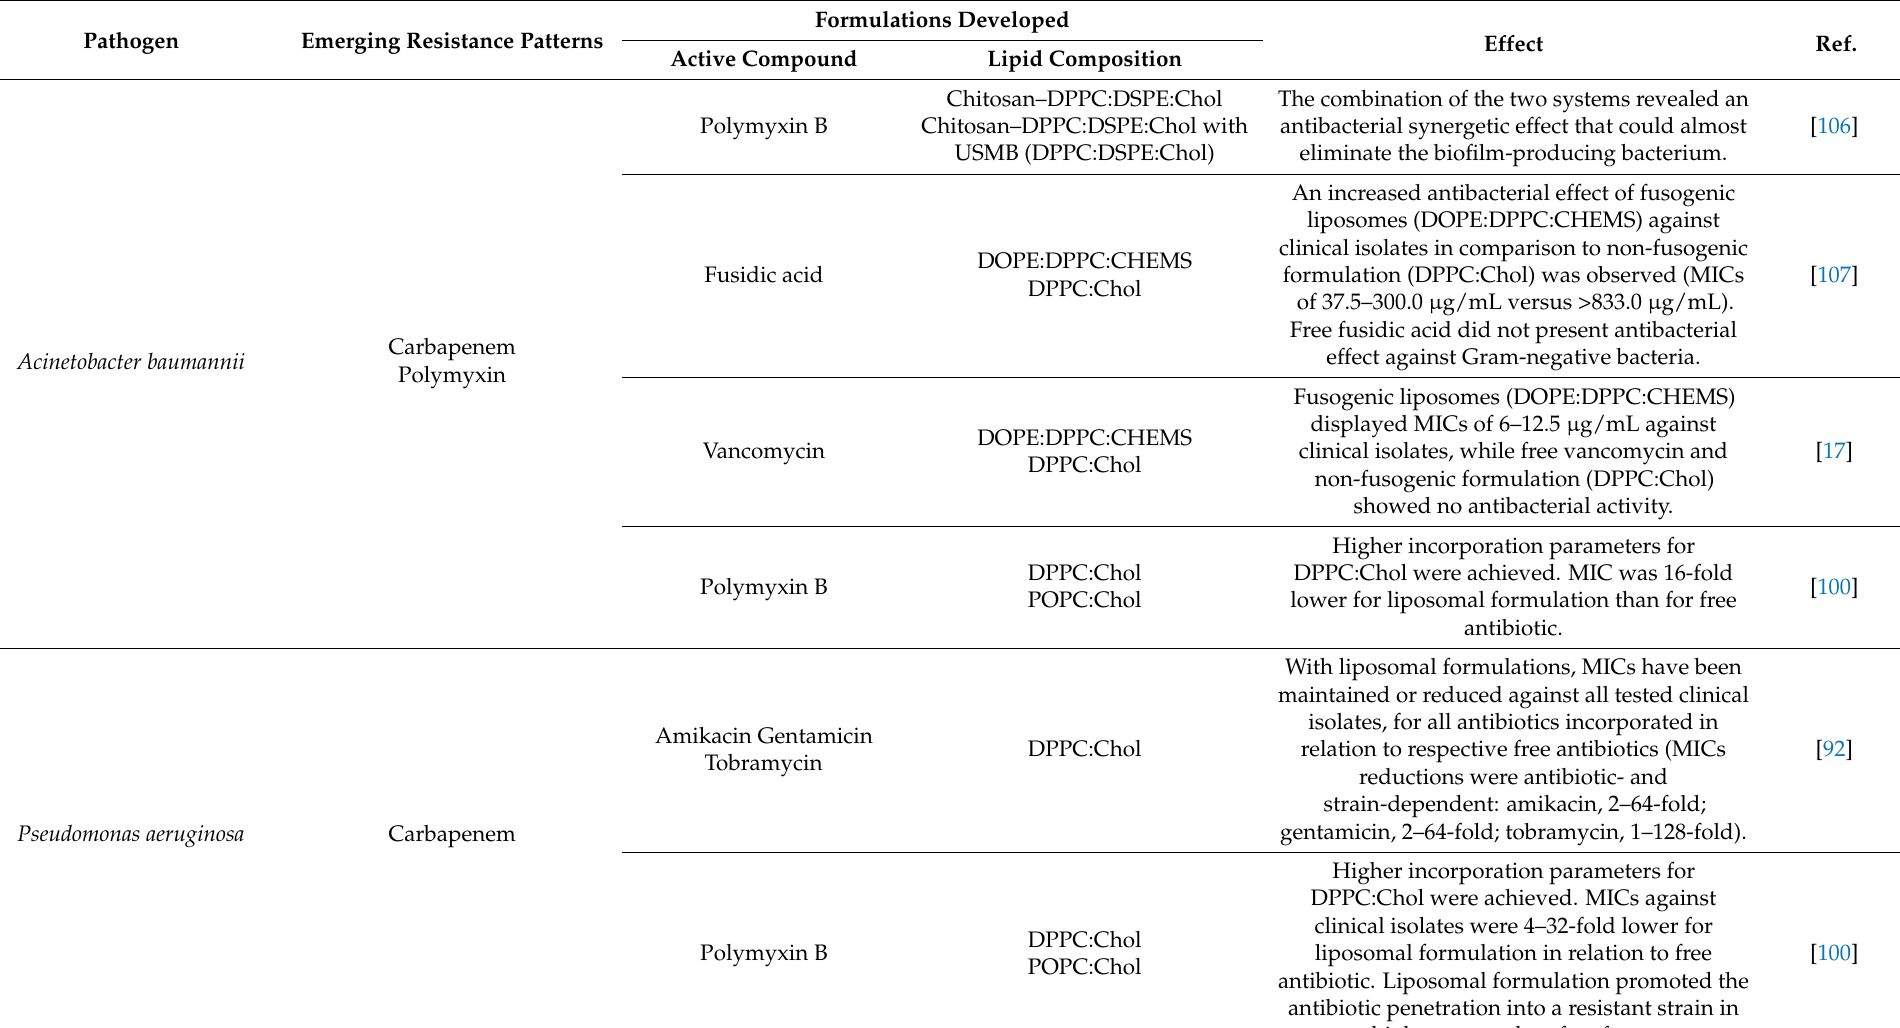
Table 2. Liposomal formulations developed for MDR